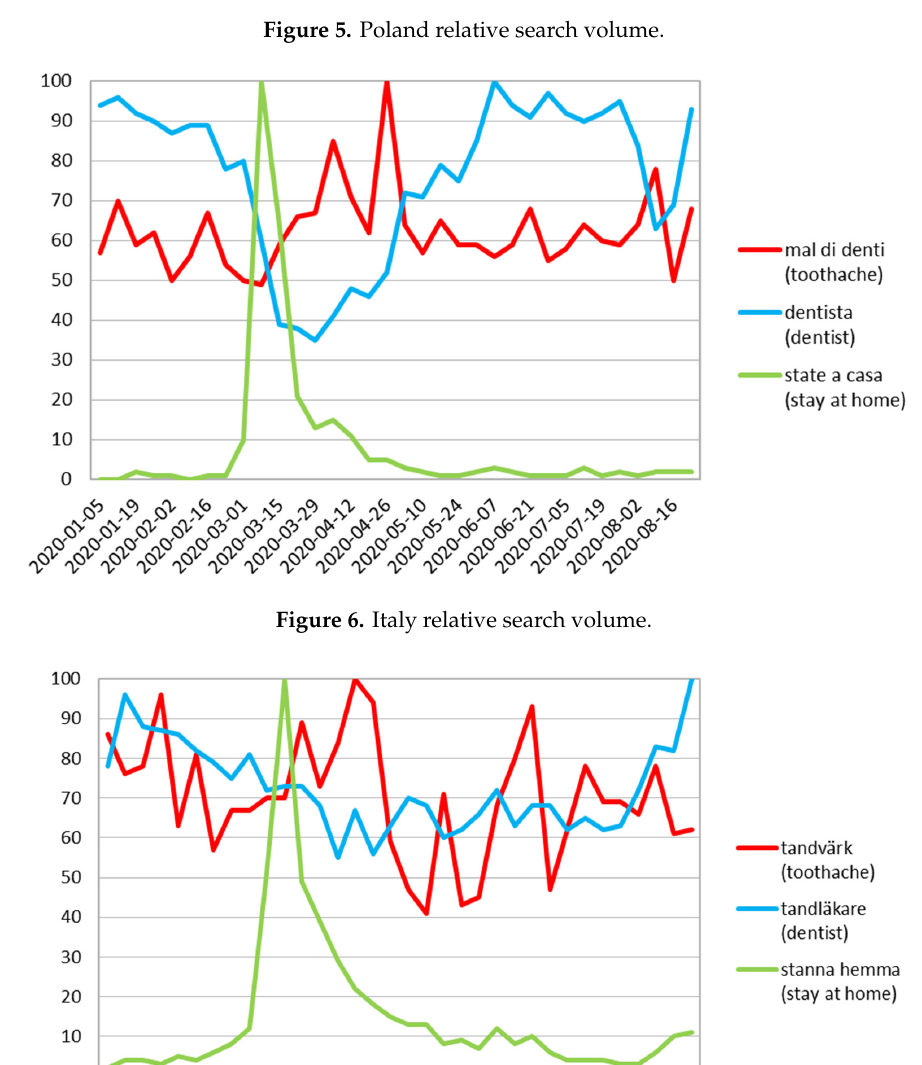
Figure 5. Poland relative search volume.